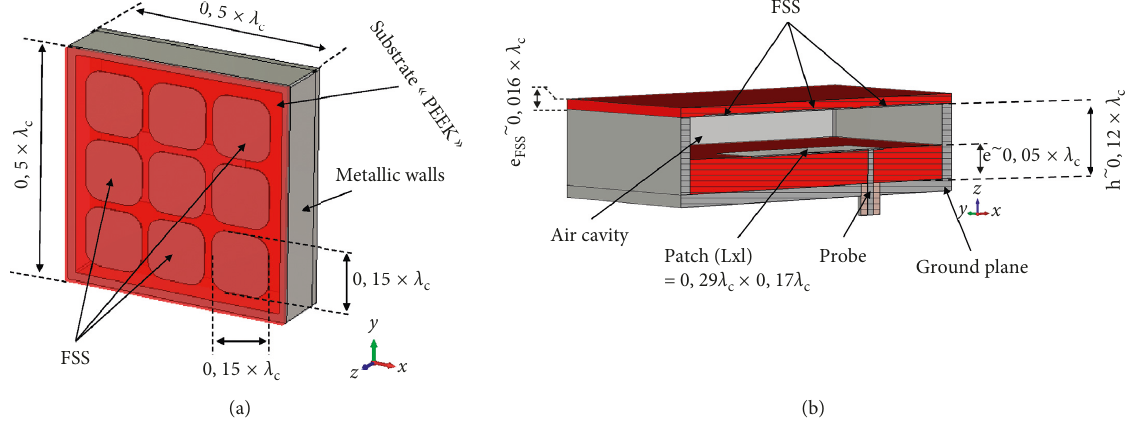
Figure 5: Pixel antenna design. (a) Perspective view. (b) Cut view along “Y.”